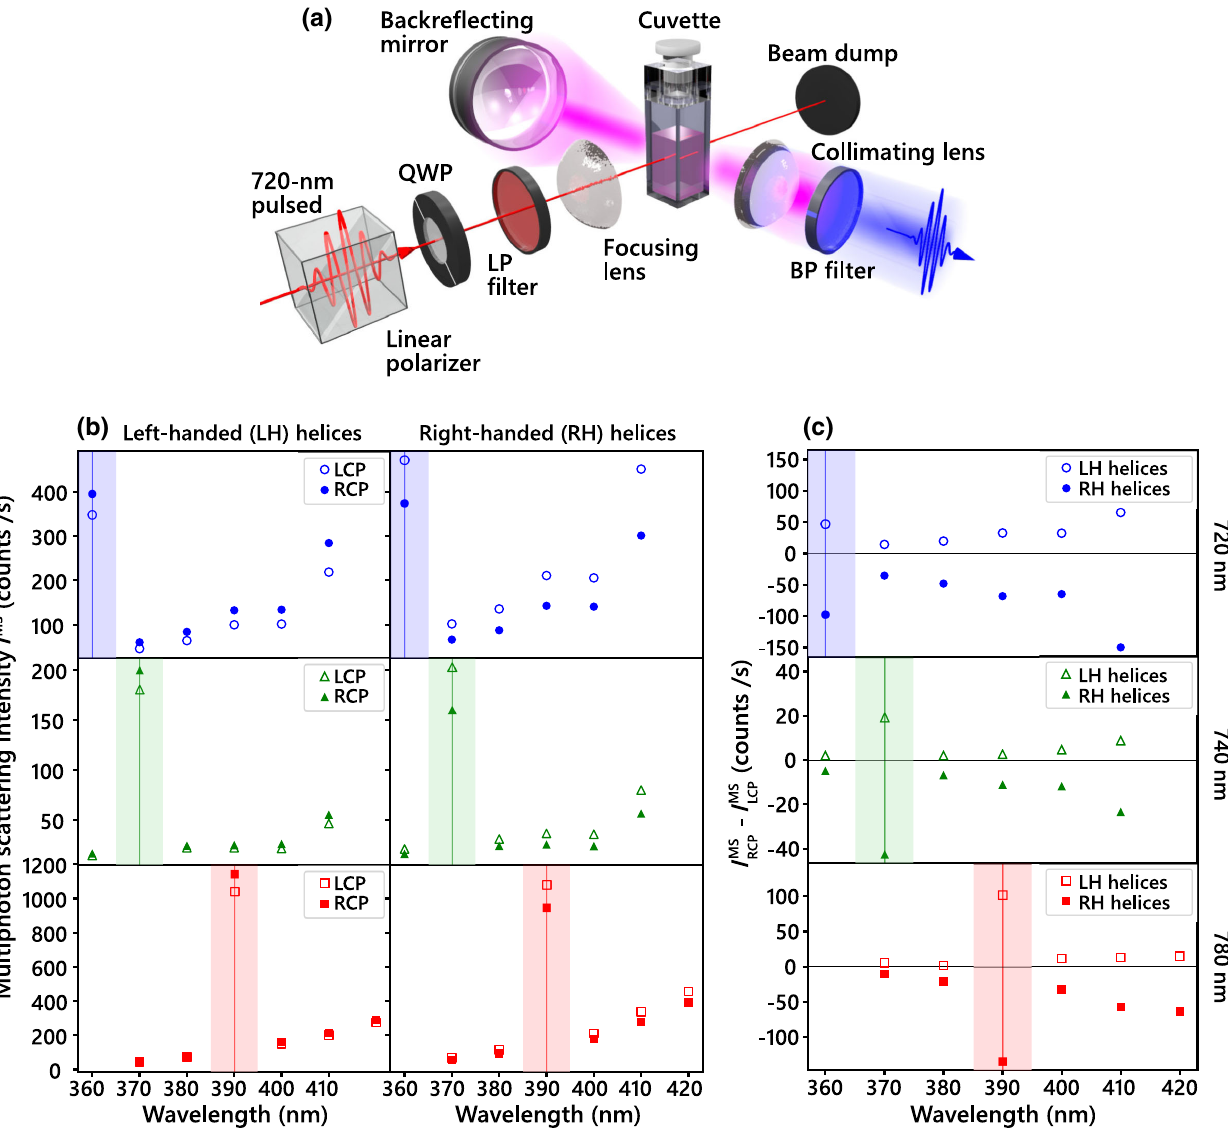
FIG. 2. Clear hyper-Rayleigh scattering signal depending on the chirality of the nanohelices, against the multiphoton luminescence background. (a) Schematic diagram of the hyper-Rayleigh scattering circular dichroism experimental setup. QWP, quarter-wave plate; LP filter, long-pass filter; BP filter, band-pass filter. (b) Multiphoton scattering spectra for left- and right-handed helices, under LCP and RCP illumination. Results obtained for fundamental wavelengths of 720, 740, and 780 nm are shown in blue, green, and red, respectively. Vertical colored lines mark the HRS (second-harmonic) wavelength, demonstrating clear peaks above the multiphoton luminescence background. The HRS unambiguously follows variations of the fundamental. The error bars are well within each symbol − I MS shown. (c) Circular difference ( I MS ) in multiphoton scattering intensity for both left-handed (LH) and right-handed (RH) RCP LCP nanohelix suspensions. Again, pump wavelengths of 720, 740, and 780 nm are shown in blue, green, and red, respectively, and vertical colored lines mark the HRS (second-harmonic) wavelength. The HRS circular difference clearly reverses between nanohelix